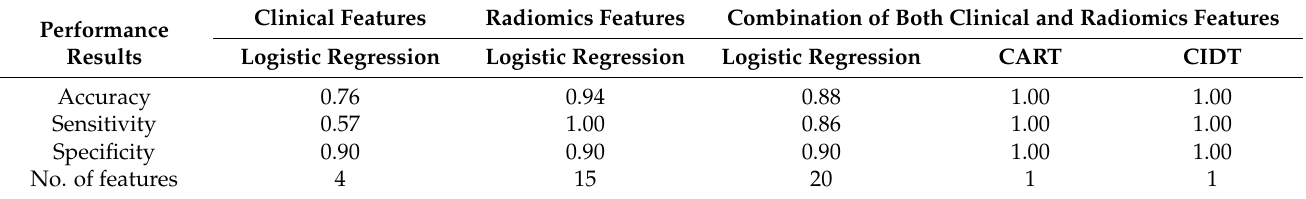
Table 4. Multivariate analysis. Results of machine learning approaches (logistic regression and tree-based algorithms) in the prediction of metastatic lymph